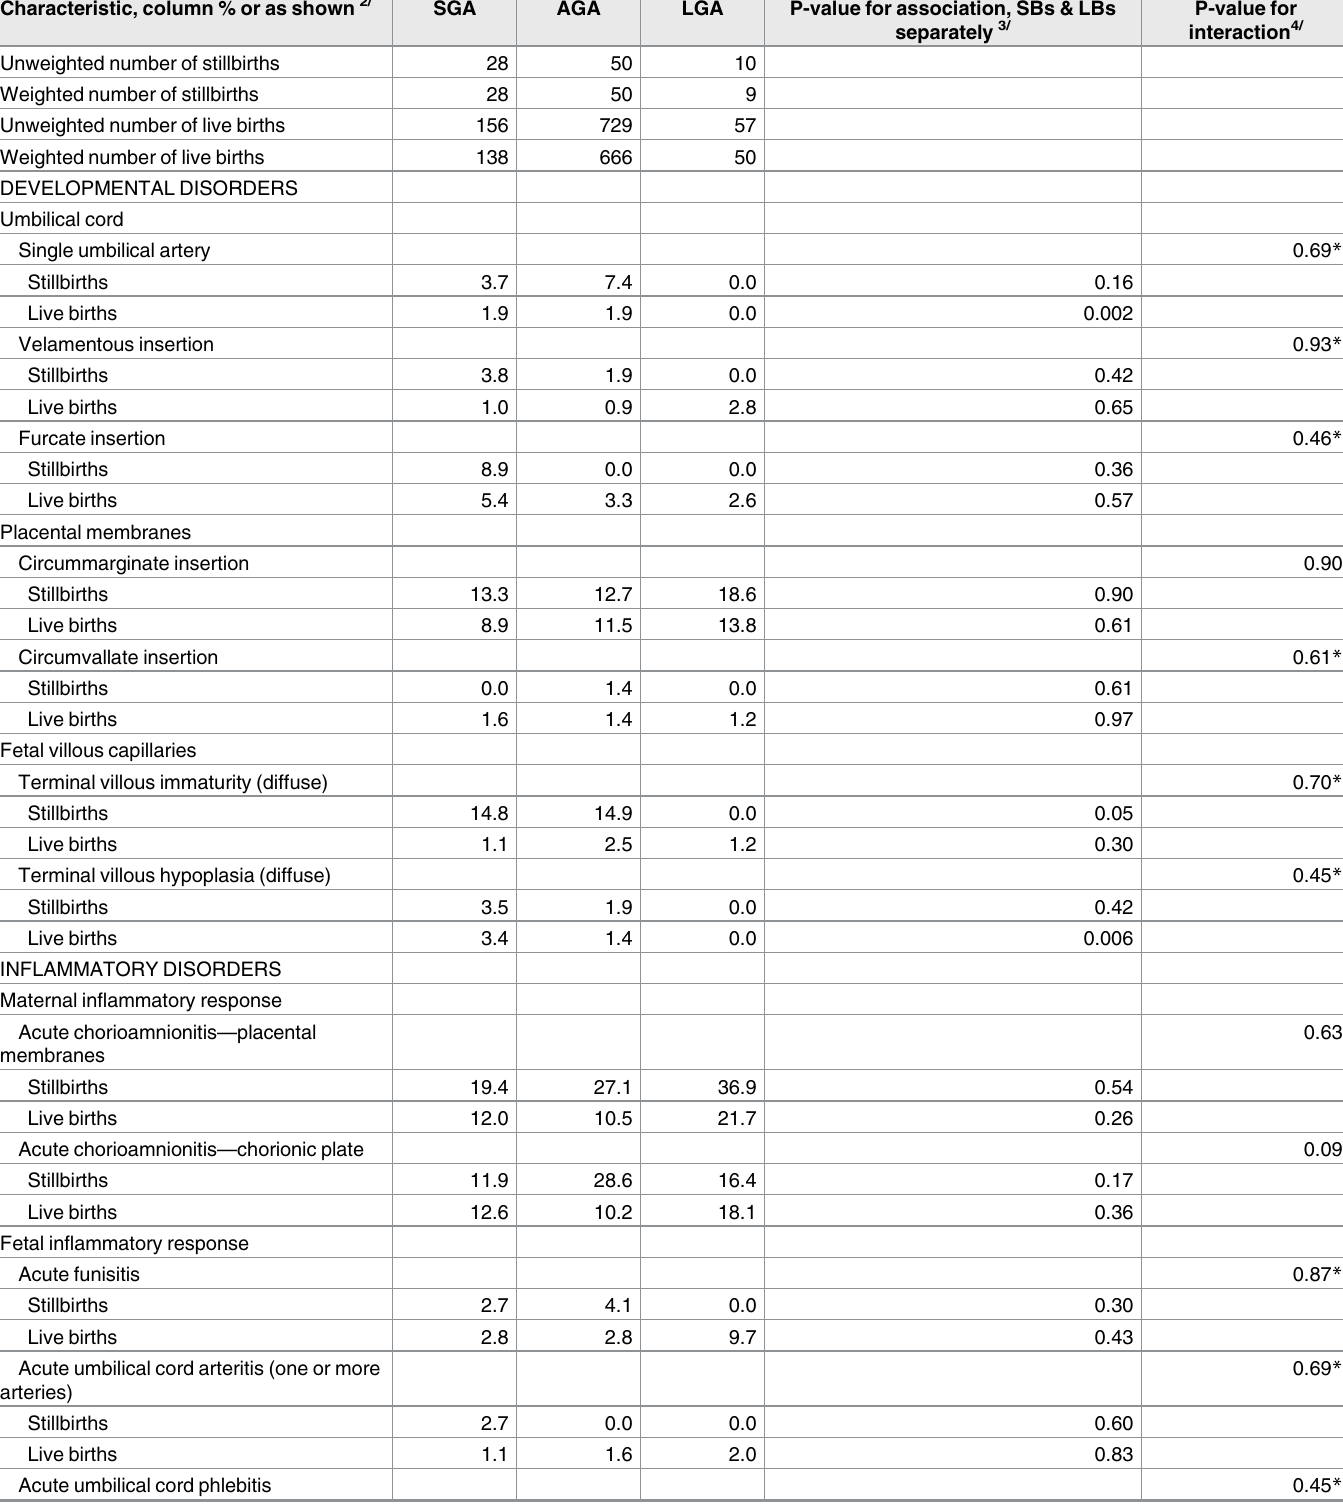
Characteristic, column % or as shown